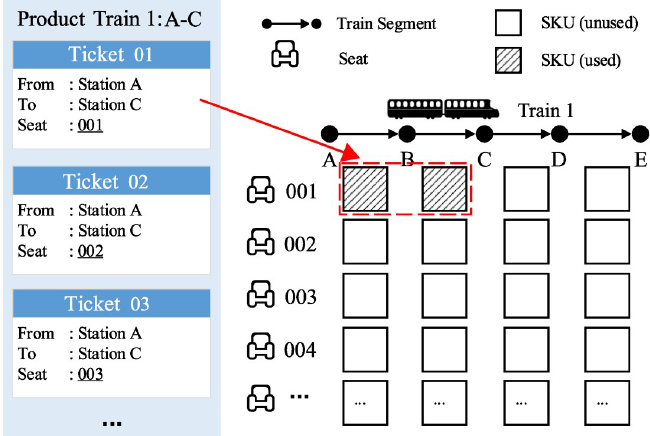
Fig 1. Illustration of basic elements (Reprinted from https://doi.org/10.1371/journal.pone.0201718.g001 under a CC BY license, with perimission from PLOS, orginal copyright 2018).